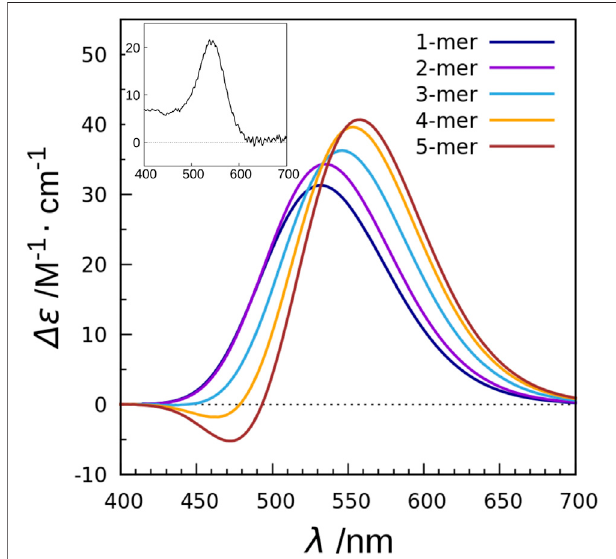
FIGURE 8 | CD spectra calculated with the exciton model for monomer to pentamer in KR2. The values are given per monomer. The experimental absorption spectrum of KR2 (Shibata et al., 2018) is shown in the